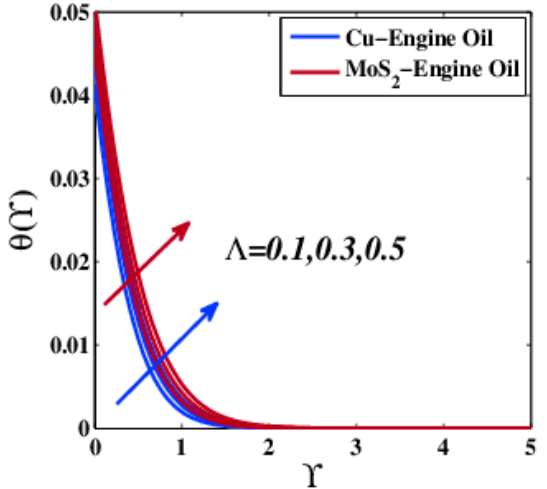
Figure 16. Velocity variation f (cid:48) ( Y ) under the influence of Λ .